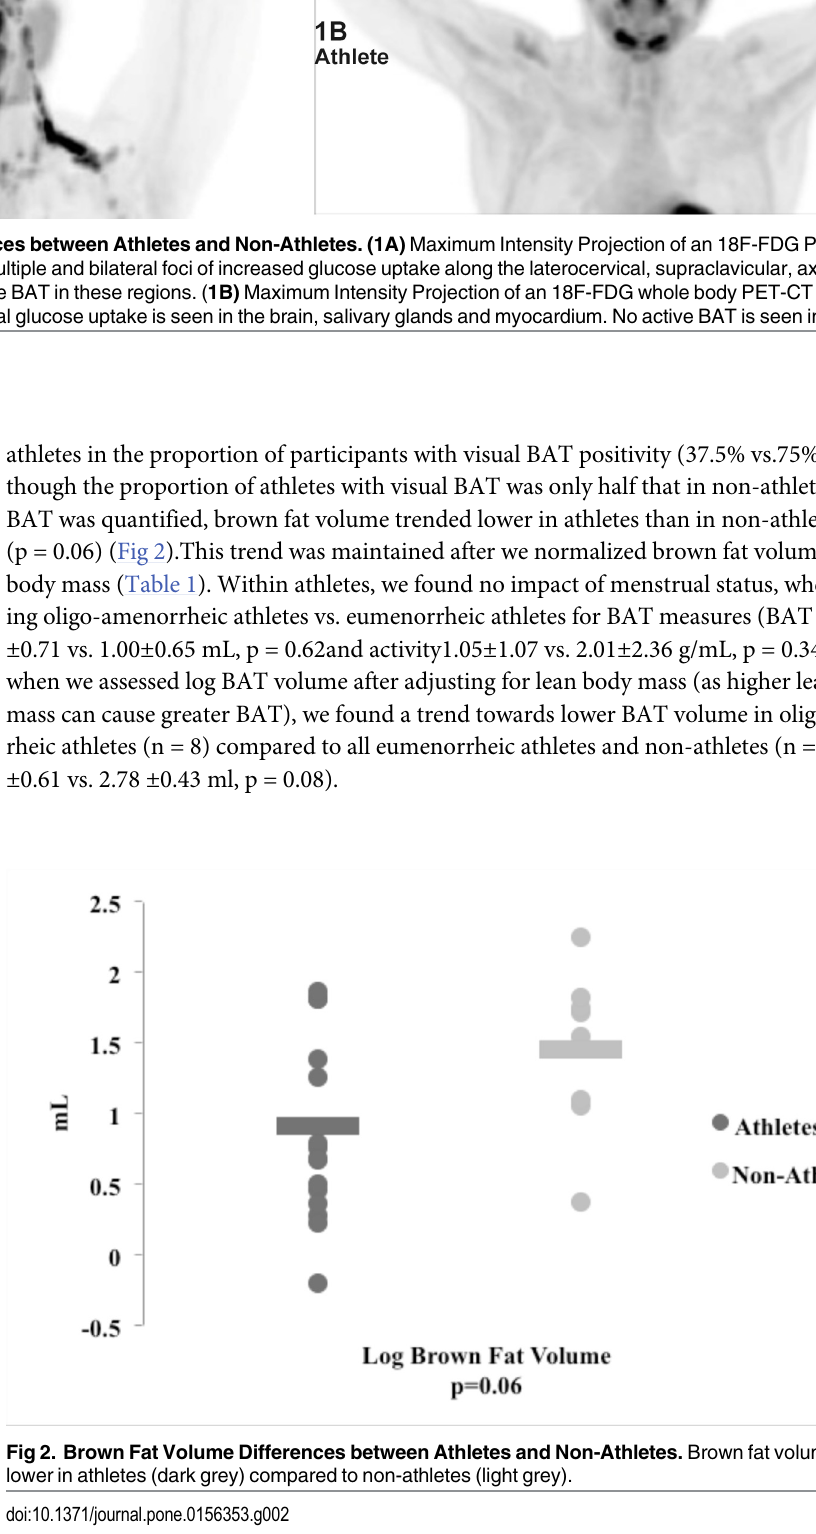
PLOS ONE | DOI:10.1371/journal.pone.0156353 May 31,